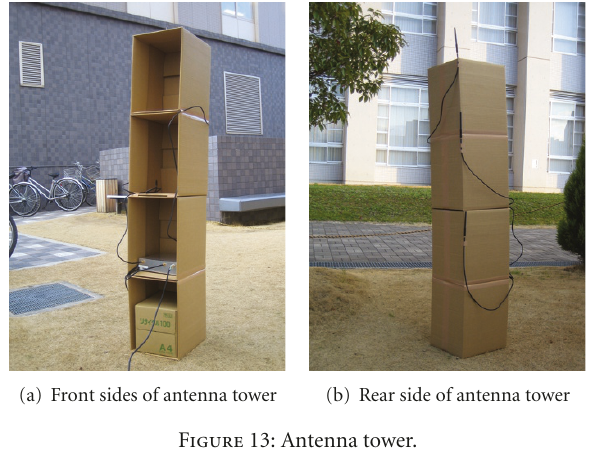
Figure 13: Antenna tower.